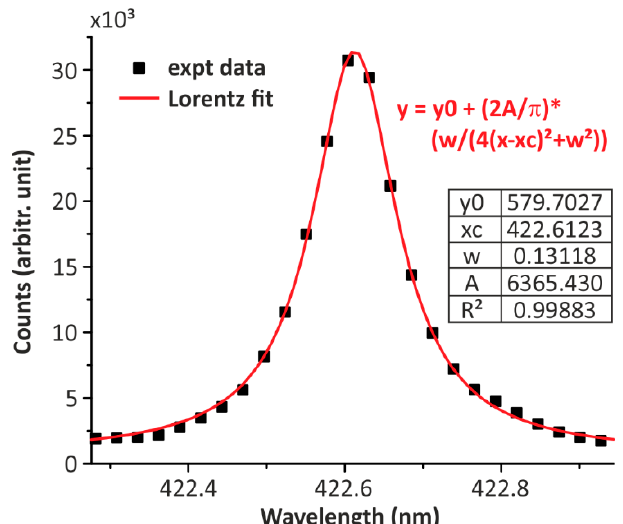
Figure 5. Lorentzian plot of the atomic line of Ca present in the LIB spectra of sample S_1. Table 5. Table for the lower limit and the calculated value of electron density.